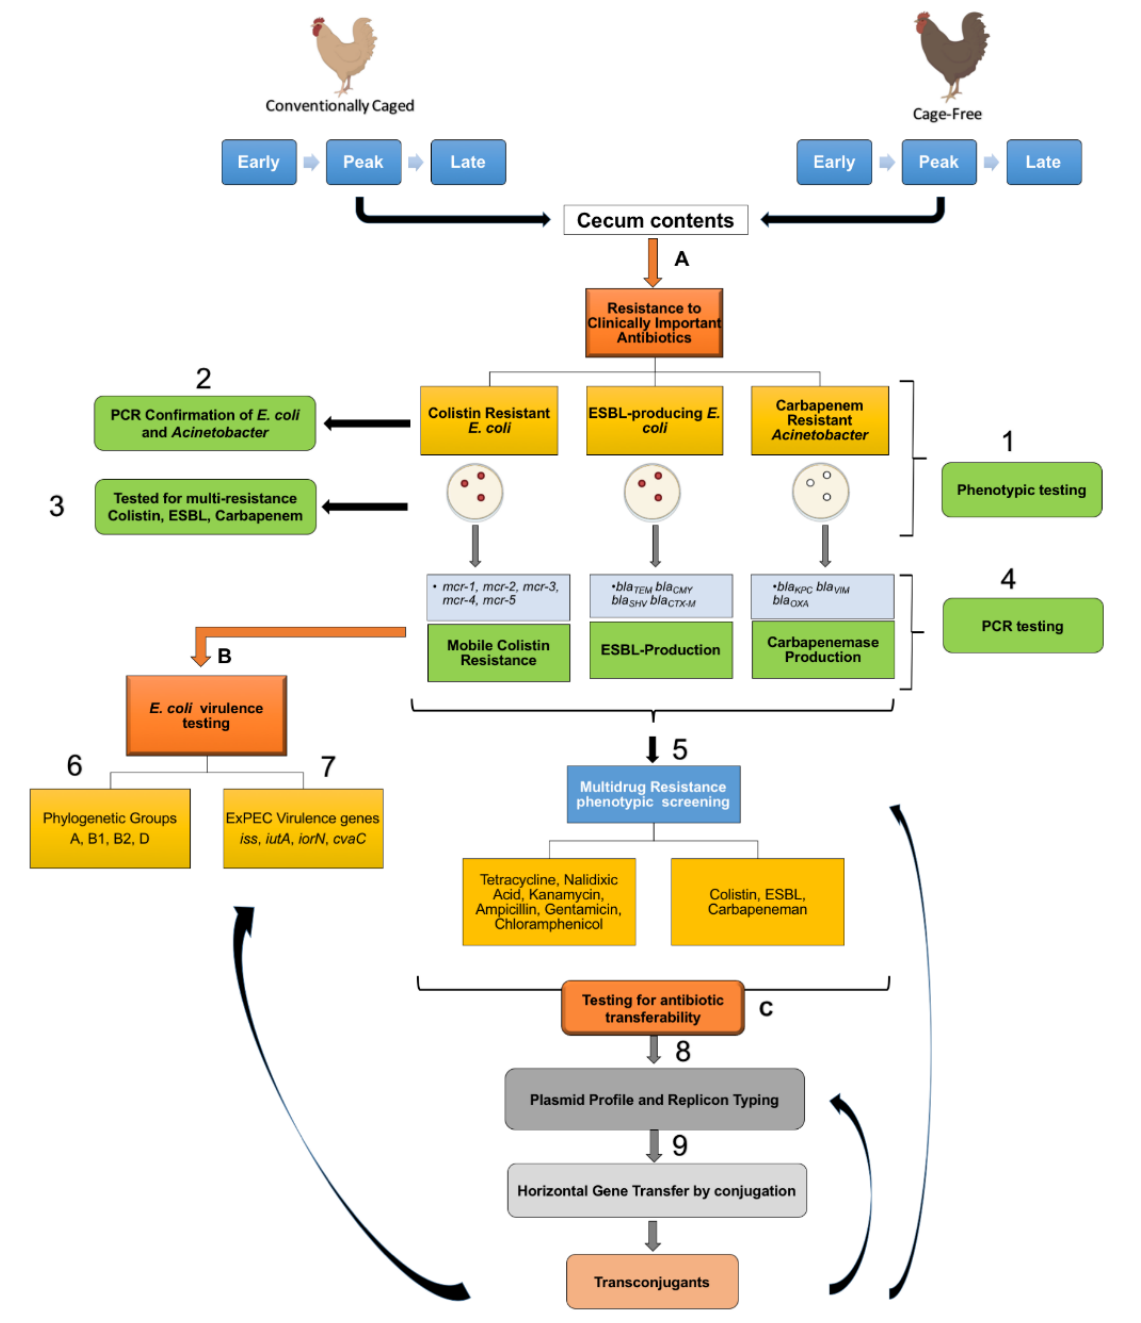
Figure 1. Graphic description of sample analysis. Ceca contents from hens at different maturity stages (early, peak, and late) from conventional cage and cage-free poultry farms were analyzed for ( A ) resistance to clinically important antibiotics, ( B ) E. coli virulence genes and phylotype, and ( C ) plasmid profiles and transferability.